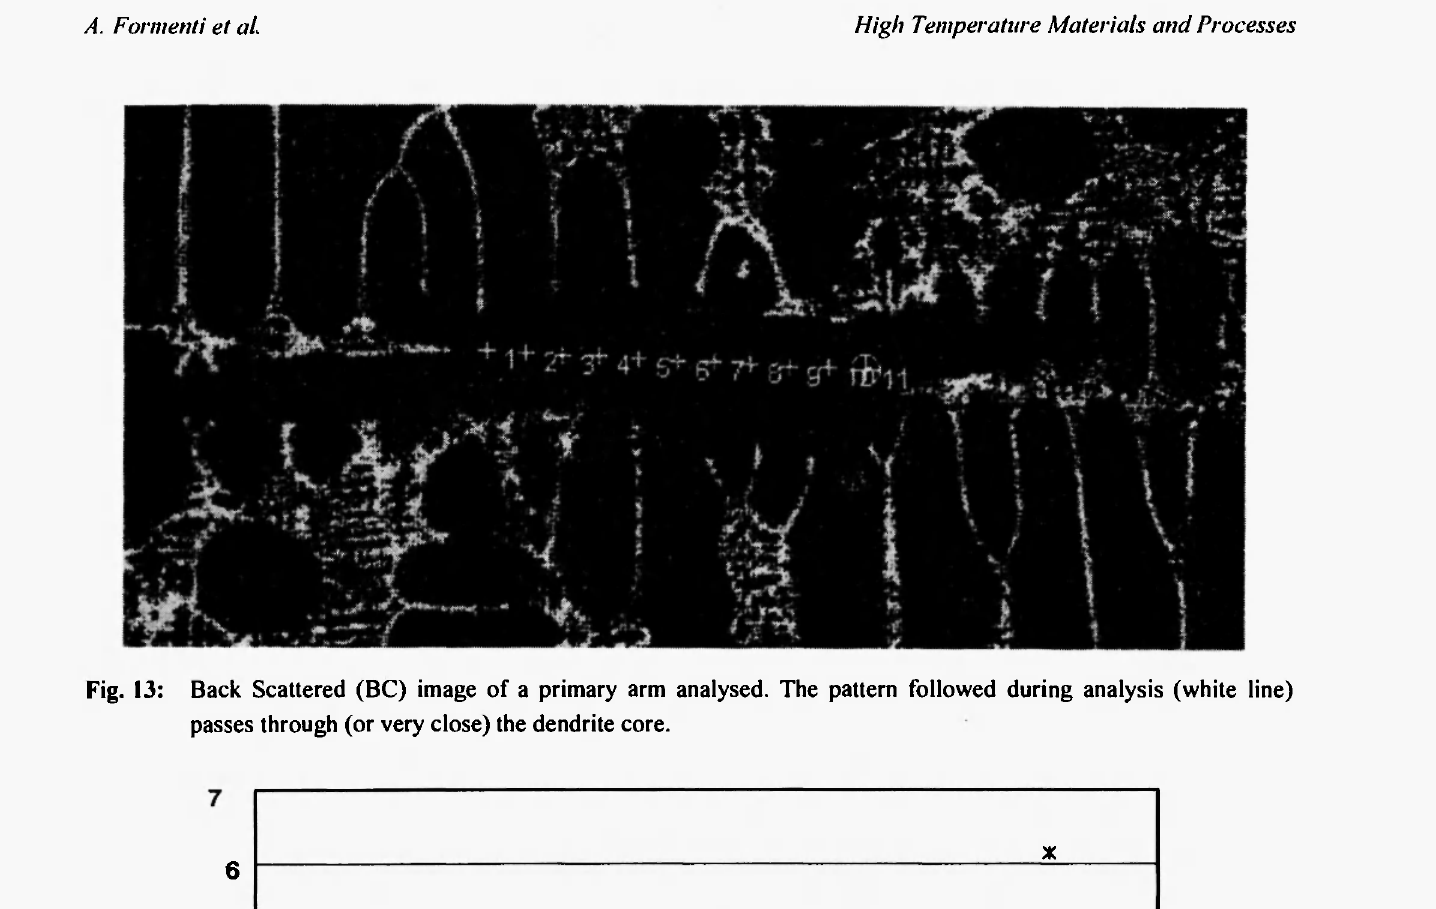
Fig. 13: Back Scattered (BC) image of a primary arm analysed. The pattern followed during analysis (white line) passes through (or very close) the dendrite core.